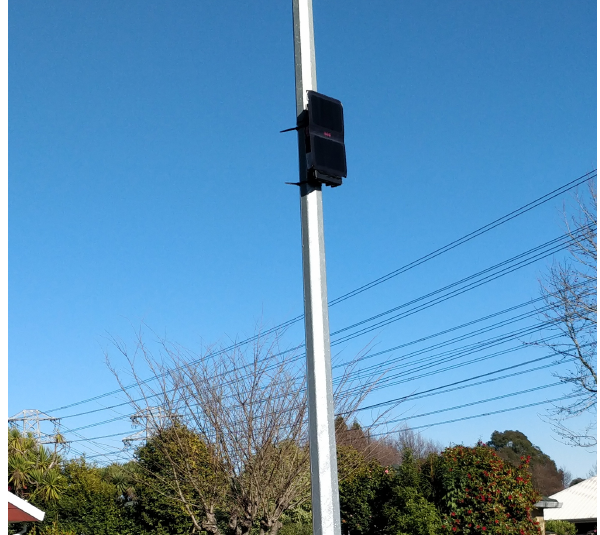
Figure 4. An example of a typical ODIN installation on a light-